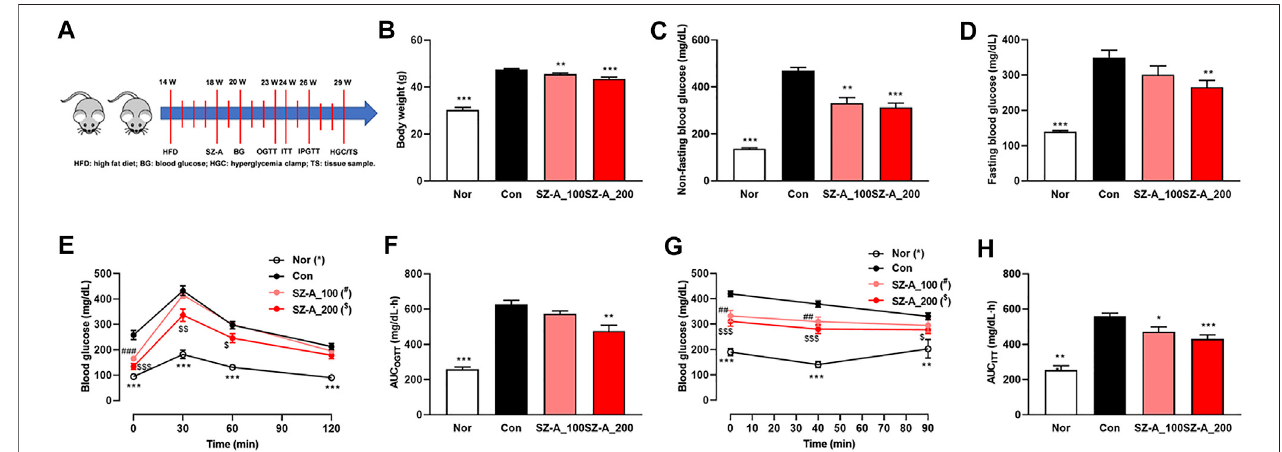
FIGURE 1 | SZ-A alleviated hyperglycemia and glucose intolerance in type 2 diabetic KKA y mice. KKA y mice were treated with 100 or 200 mg/kg SZ-A or vehicle orally once per day ( n = 10 mice per group). (A) Timeline of the animal experiment. (B) Body weight. (C) Non-fasting blood glucose levels. (D) Fasting blood glucose. (E) Oralglucose tolerance test (OGTT) and (F) areaunderthe curve (AUC)oftheOGTT. (G) Insulin tolerance test (ITT) and (H) area under the curve (AUC) ofthe ITT. All data are expressed as the mean ± SEM. * p < 0.05, ** p < 0.01, *** p < 0.001, vs. the Con